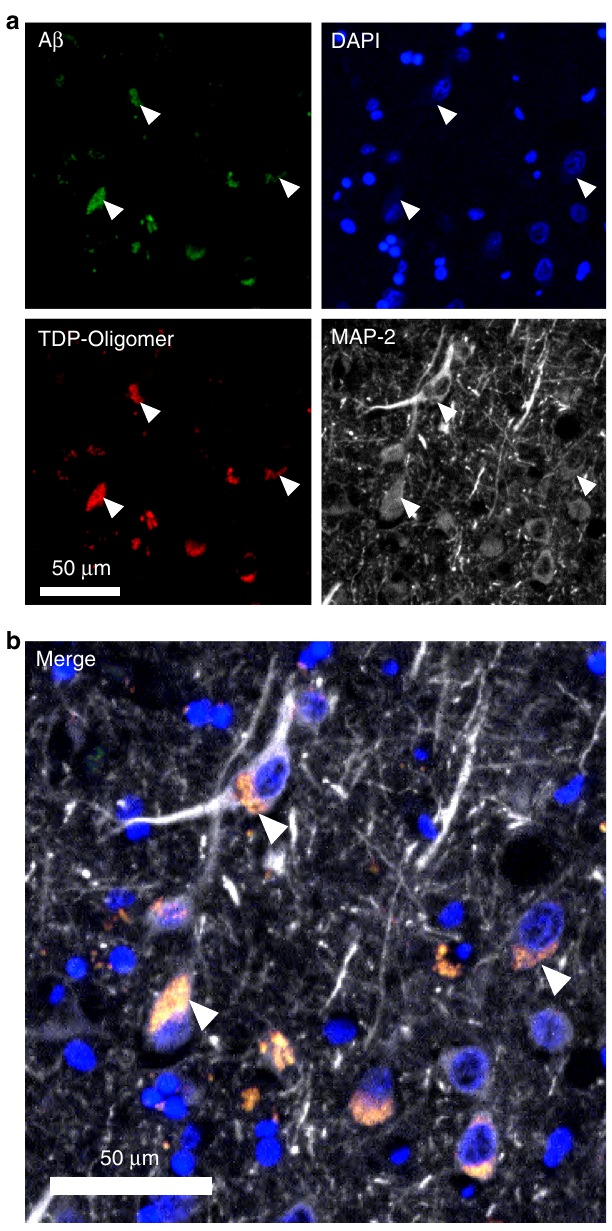
Fig. 9 TDP-43 oligomers colocalize with A β in the cytoplasmic region of neurons of an AD patient. Representative immunostaining micrographs reveal that intraneuronal A β (arrowhead) colocalize with TDP-43 in the entorhinal cortex of a 77-year-old patient with Braak stage IV AD. a Specimens are stained with A β antibodies (4G8 and 6E10), TDP-43 oligomer antibody, neuronal marker MAP-2, and DAPI. b The merged image is shown. The results demonstrated that many TDP-43 oligomers and A β colocalized in the cytoplasm of neuronal cells. Four induvial samples were performed. Source data are provided as a Source Data fi species of AD patients with hyperphosphorylated TDP-43 ( n = 3) were lower and their levels of A β oligomers were higher than those of AD patients but without TDP-43 pathology ( n = 5). A β oligomer at 50 kDa was signi fi cantly higher in AD patients with TDP-43 pathology than in AD patients but without TDP-43 pathology. These results were consistent with those observed in APP/PS1 Δ E9 mice injected with TDP-43.